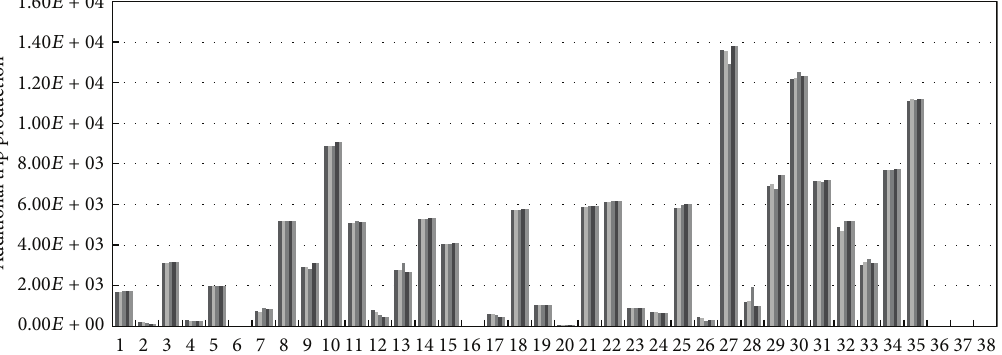
Figure 5: Solutions of additional trip production from five start points on